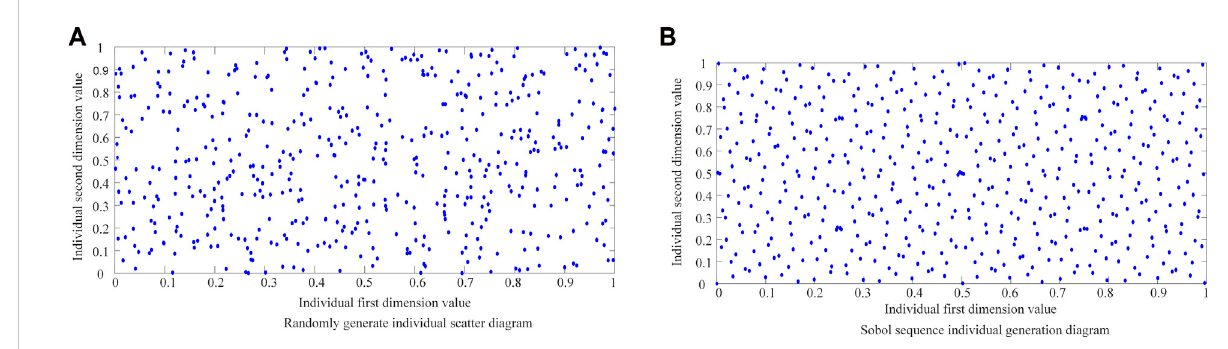
FIGURE 11 Distribution of individuals generated by random method and Sobol sequence.